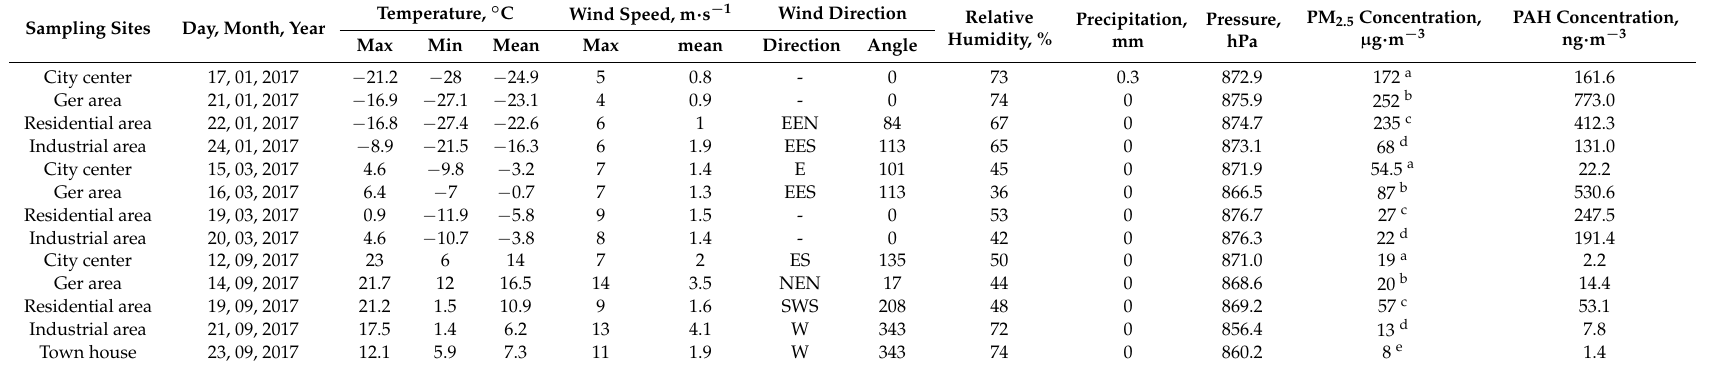
Table 2. Meteorological conditions and PM 2.5 and PAHs concentrations during the sampling